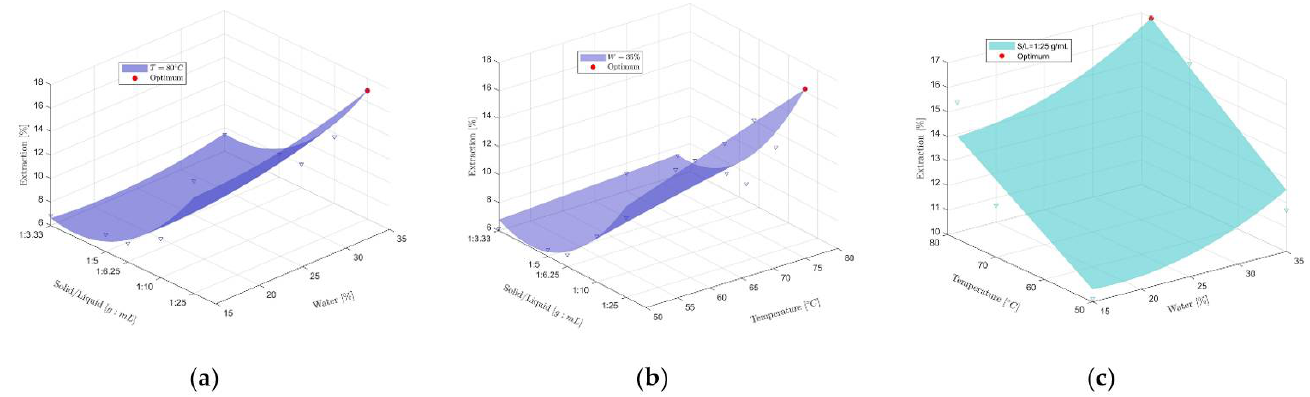
Figure 4. Three-dimensional plots of response surfaces for the effects on the response of ( a ) the solid-to-liquid ratio and percentage of water (g GAE 100 g −1 of skin) at three different temperatures; ( b ) the solid-to-liquid ratio and temperature (g GAE 100 g −1 of skin) at two different percentages of water; ( c ) the temperature and percentage of water (g GAE 100 g −1 of skin) at five different solid-to-liquid ratios.